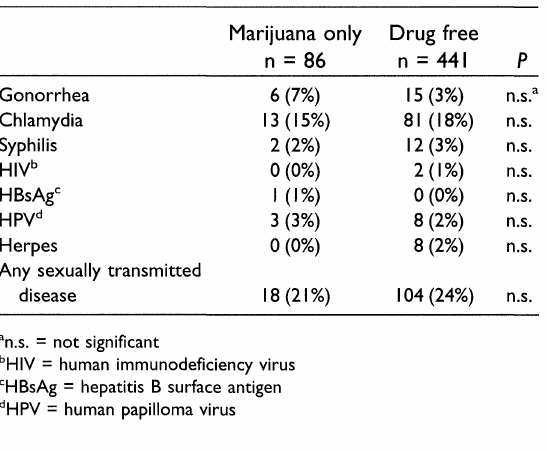
TABLE 2. Occurrence of sexually transmitted disease and marijuana use during pregnancy Marijuana